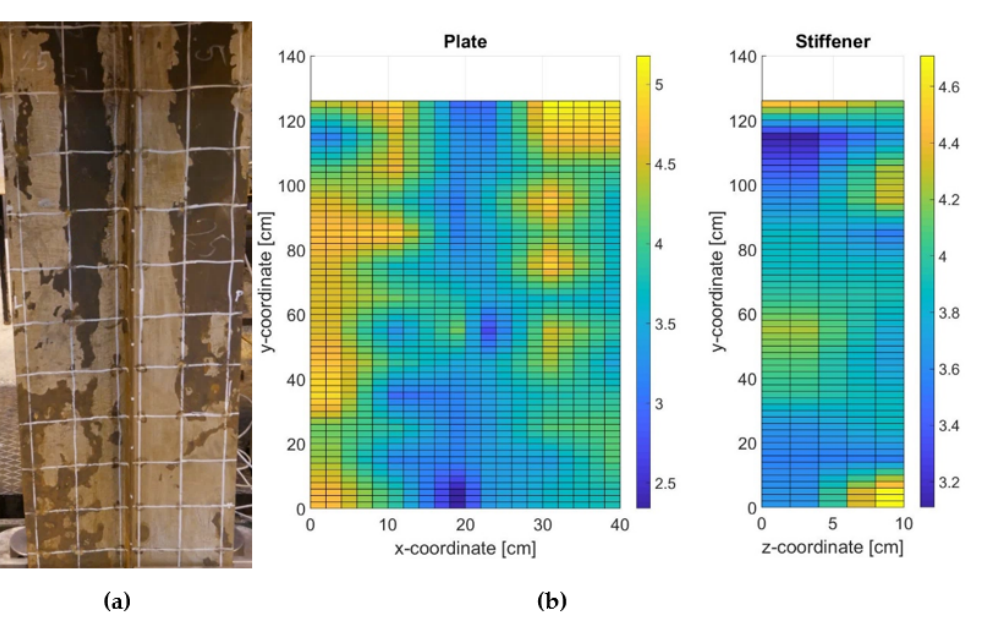
Figure 9. Example of a stiffened plate ( a ) within thickness distribution ( b ) in [mm]